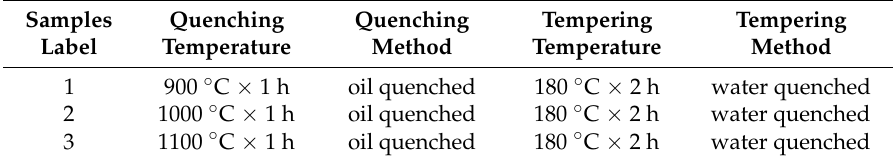
Table 2. Heat treatment of 17Cr2Ni2MoVNb